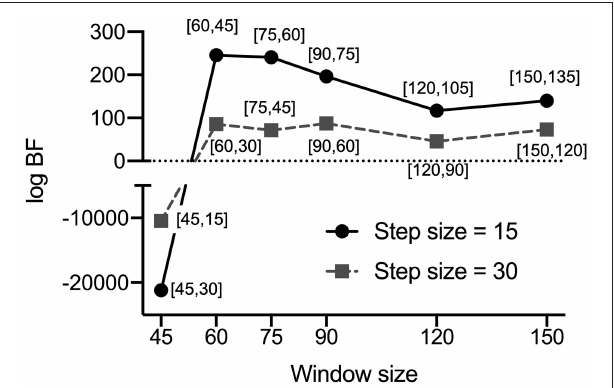
FIGURE 5 | Window size and overlap size-dependent log Bayes factors (BF) for the experimental data. The log BFs of the 12 pairs of window sizes and overlap sizes in the PEB analysis are presented. According to Zarghami and Friston (2020), we determined the optimal window size and overlap size by maximizing the relative log evidence (or the log BF) of a dynamic state model compared with a stationary model for a given window size and overlap size in the PEB analysis. The bracket contains a pair [window size, overlap size]. Among the 12 pairs of window size and overlap size, the window size = 60 and overlap size = 45 showed the highest BF in the DMN of the current experimental data. Overlap sizes were chosen to make sliding window steps (window size minus overlap size) 15 or 30 (see Method section in